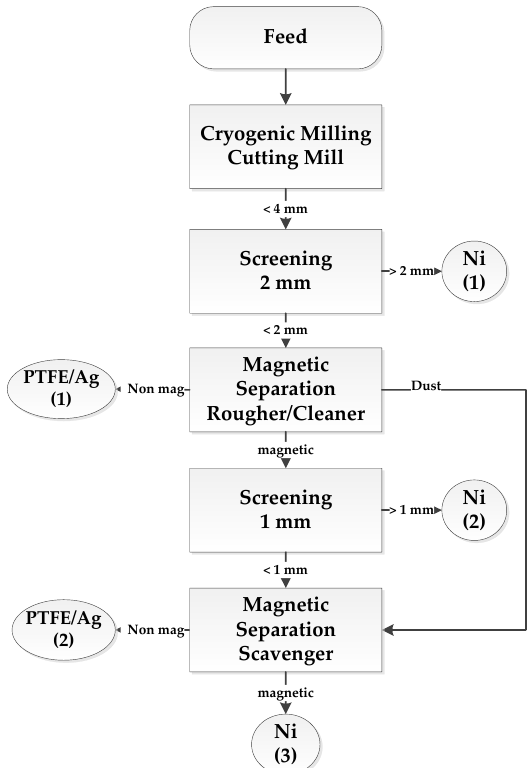
Figure 3. Simplified flow sheet of the discontinuous mechanical treatment process.